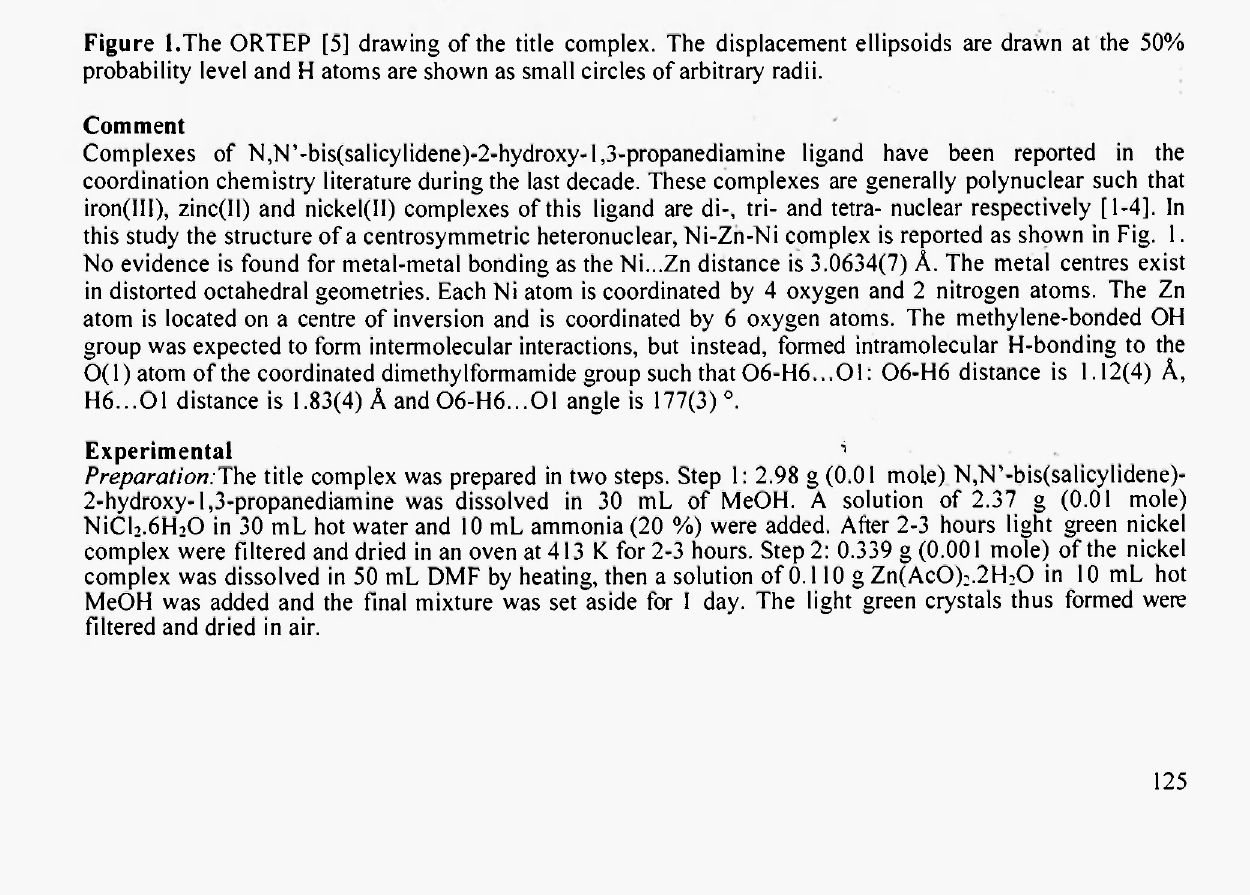
Figure l .The ORTEP [5] drawing of the title complex. The displacement ellipsoids are drawn at the 50% probability level and Η atoms are shown as small circles of arbitrary